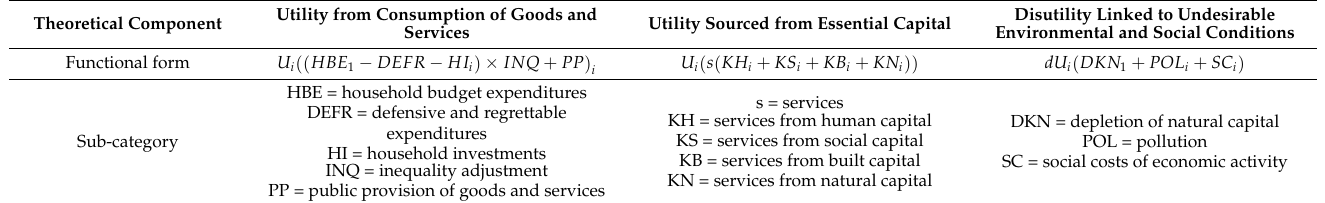
Table 2. GPI calculation components in equation (1). (Reprinted with permission from ref. [34]. Copyright 2021